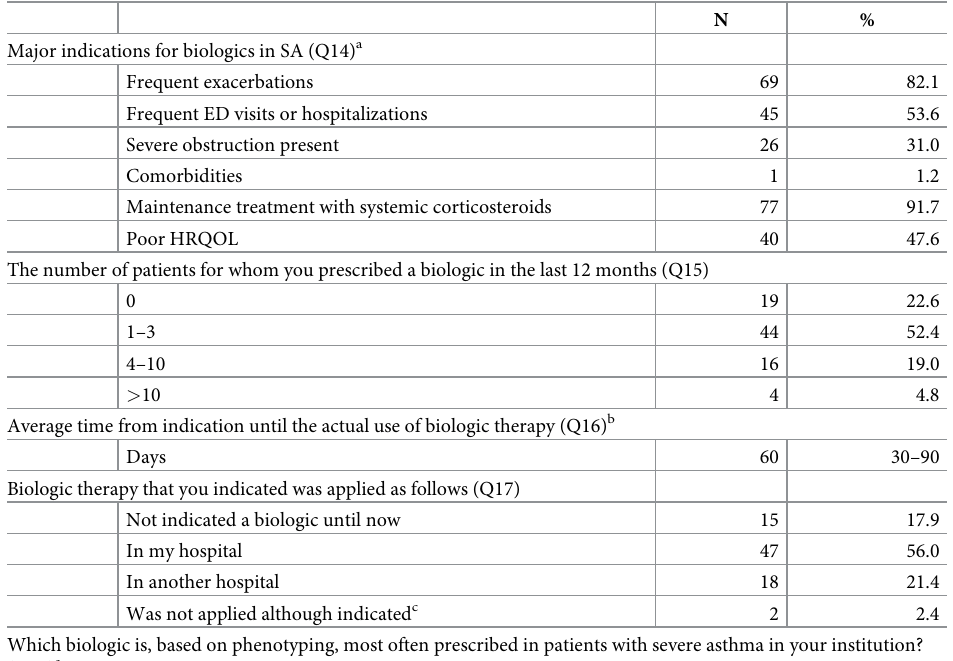
Table 4. Beliefs and attitudes about biologics in managing severe asthma (SA) (N =